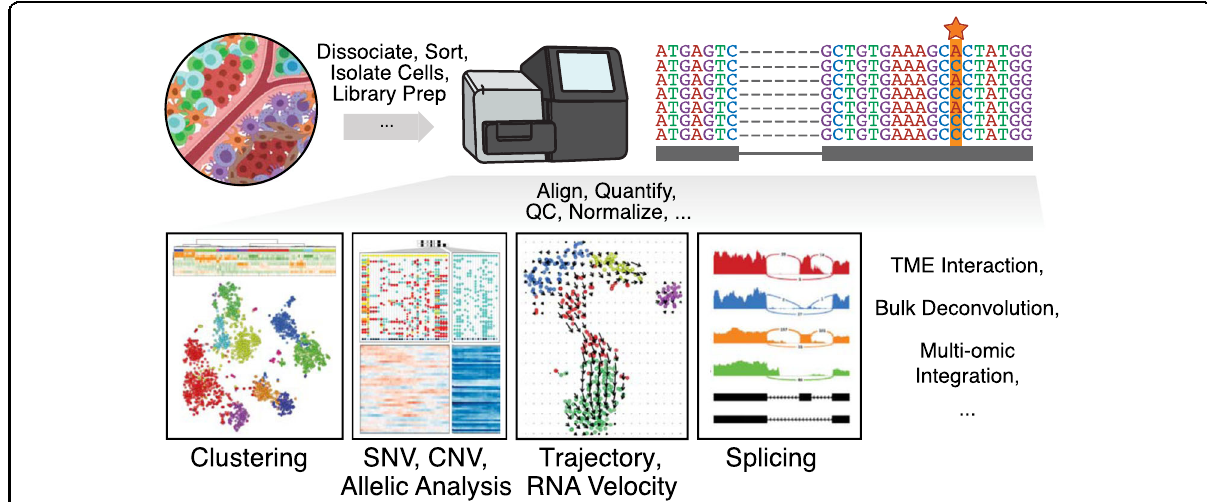
Fig. 2 Single cell RNA-seq work fl ow and downstream computational analyses. High-throughput single-cell transcriptomic technologies such as single-cell RNA sequencing generally begin with experimental work fl ows tailored to distinct tumor and tissue types (dissociating, sorting, and isolating cells, etc.), which ultimately result in sequences that can be aligned, quanti fi ed, quality control (QC) fi ltered, and normalized in different ways to enable a number of downstream computational analyses, such as clustering analysis to identify transcriptionally distinct cell types and subpopulations, allelic analysis to identify single nucleotide variants (SNVs, indicated with a star in the read pileup) or copy number variants (CNVs), trajectory analysis, splicing detection, or the inference of tumor-microenvironmental (TME) interactions.